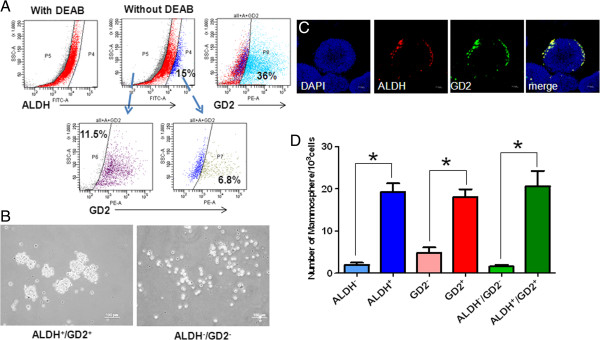
Characteristics of ALDH+/GD2+ cells. (A) The expression of Aldehyde dehydrogenase 1 (ALDH) and GD2 on xenografted BC-P007 cells was determined by flow cytometry. (B) ALDH+/GD2+ and ALDH-/GD2- cells were sorted from the xenografted BC-P007 cells and cultured in a mammosphere condition at 1,000 cells/well of 24-well plates to mammosphere formation. Representative images of mammospheres formed from ALDH+/GD2+ (left panel) and ALDH-/GD2- (right panel) cells were shown. The distribution of ALDH and GD2 expression on the mammospheres was examined by immunofluorescent microscopy with ALDH-AF594/GD2-AF488 antibodies. Single confocal sections (C) of mammospheres stained for ALDH (red), GD2 (green) and nucleus (blue) are presented. (D) The mammosphere forming capacity of the indicated cell populations sorted from BC-P007, BC-P107 and BC-P515. The mammospheres of the indicated cell populations of these three xenografted tumor cells were counted and their mean mammosphere formation efficiency was presented as the mean ± SEM of triplicate experiments from each of the three independent xenografts. *, P <0.0001.